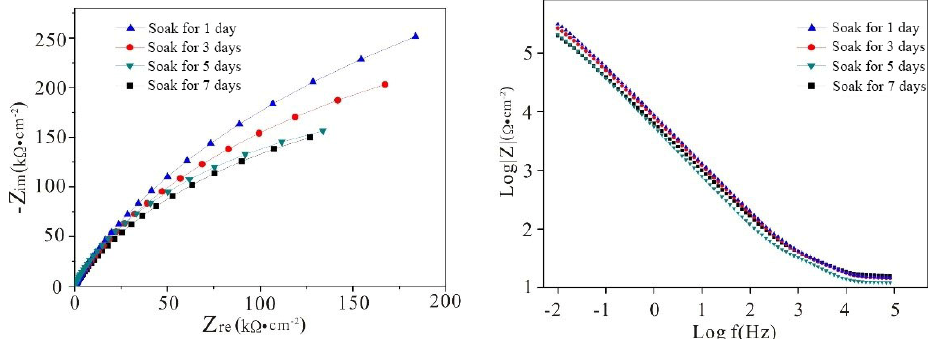
Figure 13. Nyquist and Bode plots of 3D-printed + modified samples immersed in simulated seawater for different times.